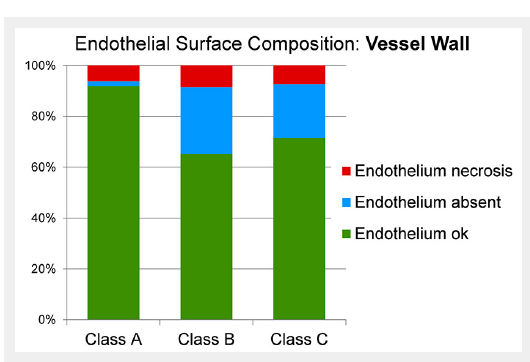
Surface analysis of the endothelium of the vessel wall in the three classes of venous disease (A: minimal; B: early stage; C: